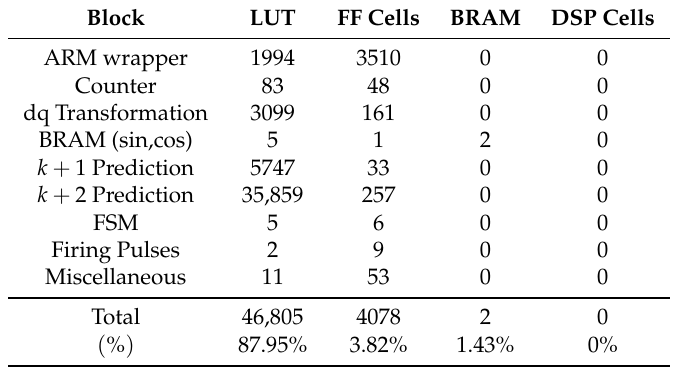
Table 5. Hierarchical utilization for parallel method. No Digital Signal Processing (DSP) cells.